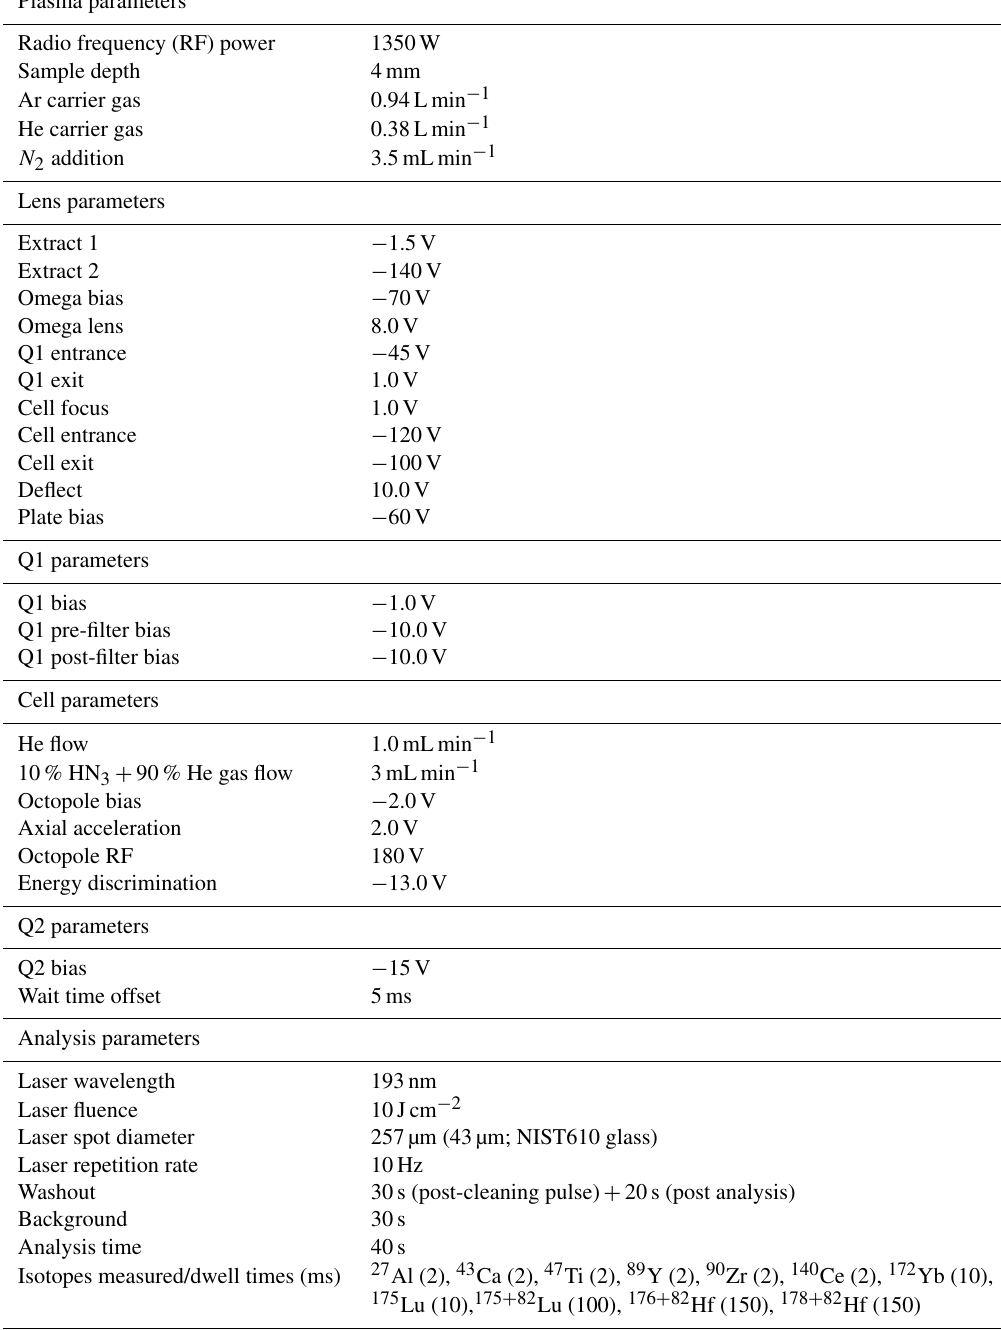
Table D1. Analysis and LA-ICP-MS/MS tuning